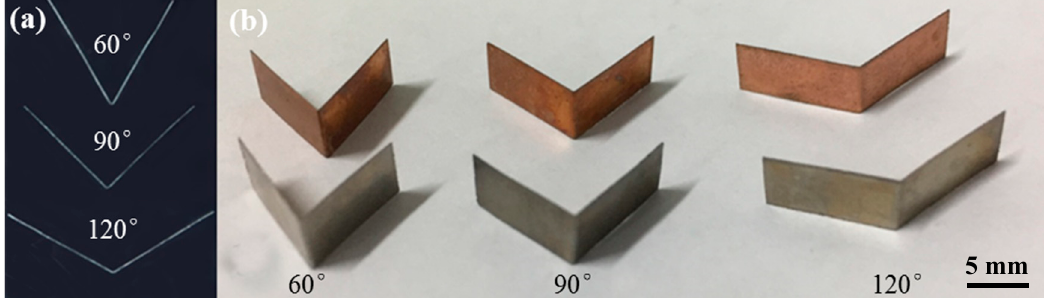
Figure 5. ( a ) Profiles and ( b ) view of bent specimens.